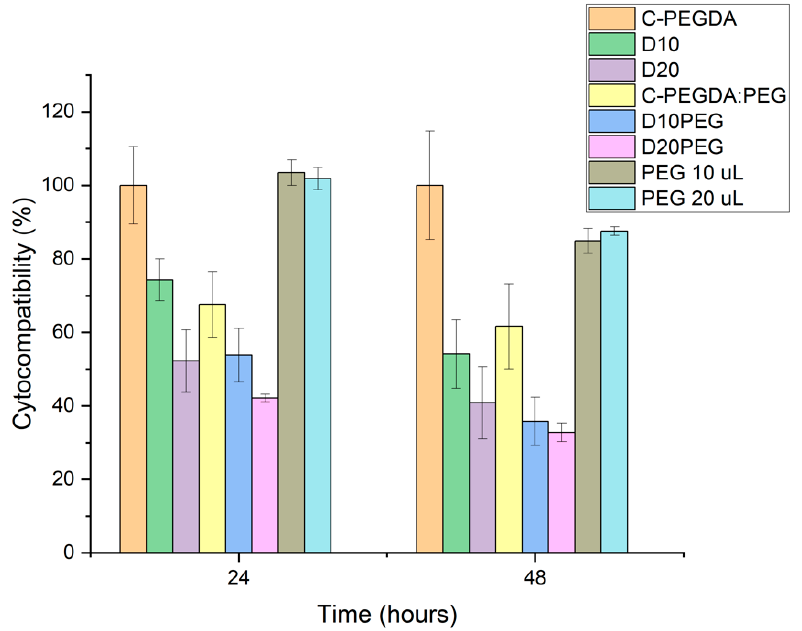
Figure 10. Viability of Balb/3T3 cells after 24 and 48 h in contact with C-PEGDA, D10, D20, C-PEGDA:PEG, D10PEG, D20PEG DLP 3D printed samples, and PEG 400 (10 μ L and 20 μ L).